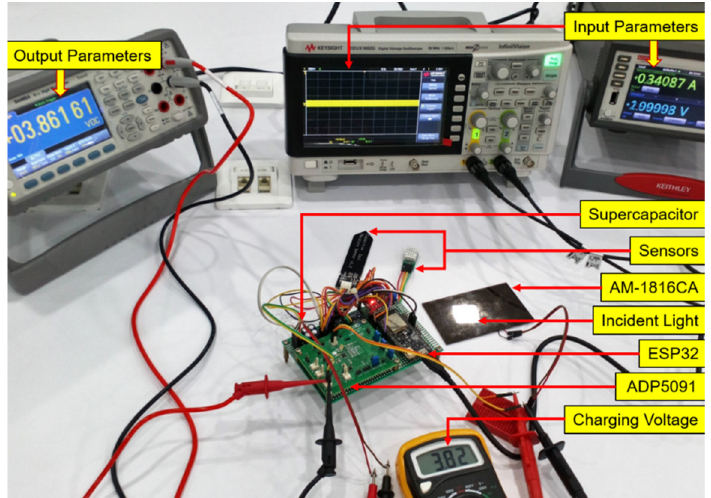
Figure 4. Experimental test bench in the laboratory, including energy source as fluorescent light, AM-1816 PV module, prototype device, wireless sensor nodes, and relevant measurement devices.